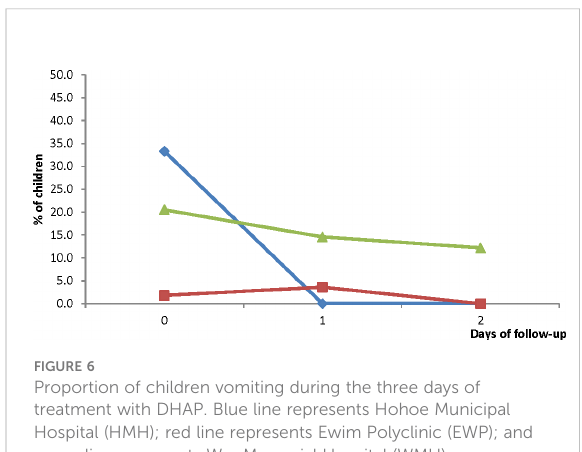
FIGURE 6 Proportion of children vomiting during the three days of treatment with DHAP. Blue line represents Hohoe Municipal Hospital (HMH); red line represents Ewim Polyclinic (EWP); and green line represents War Memorial Hospital